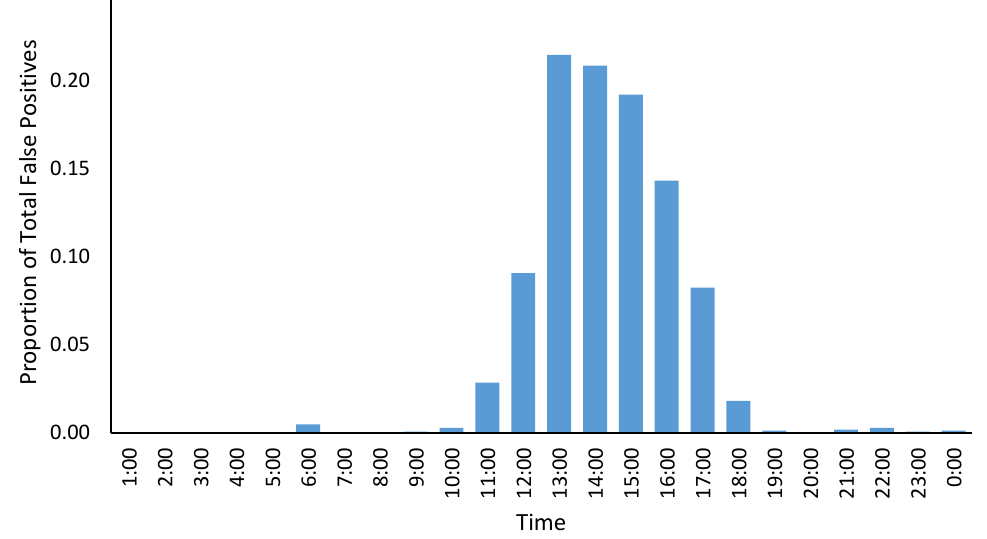
Figure 5. Proportion of false positive videos (videos for which there was no obvious triggering event and for which there was no animal visible in the field of view) by time of day. Over 85% of all false positive videos occurred in the afternoon between 12:00 and 18:00, with 95% occurring between 11:00 and 18:00.